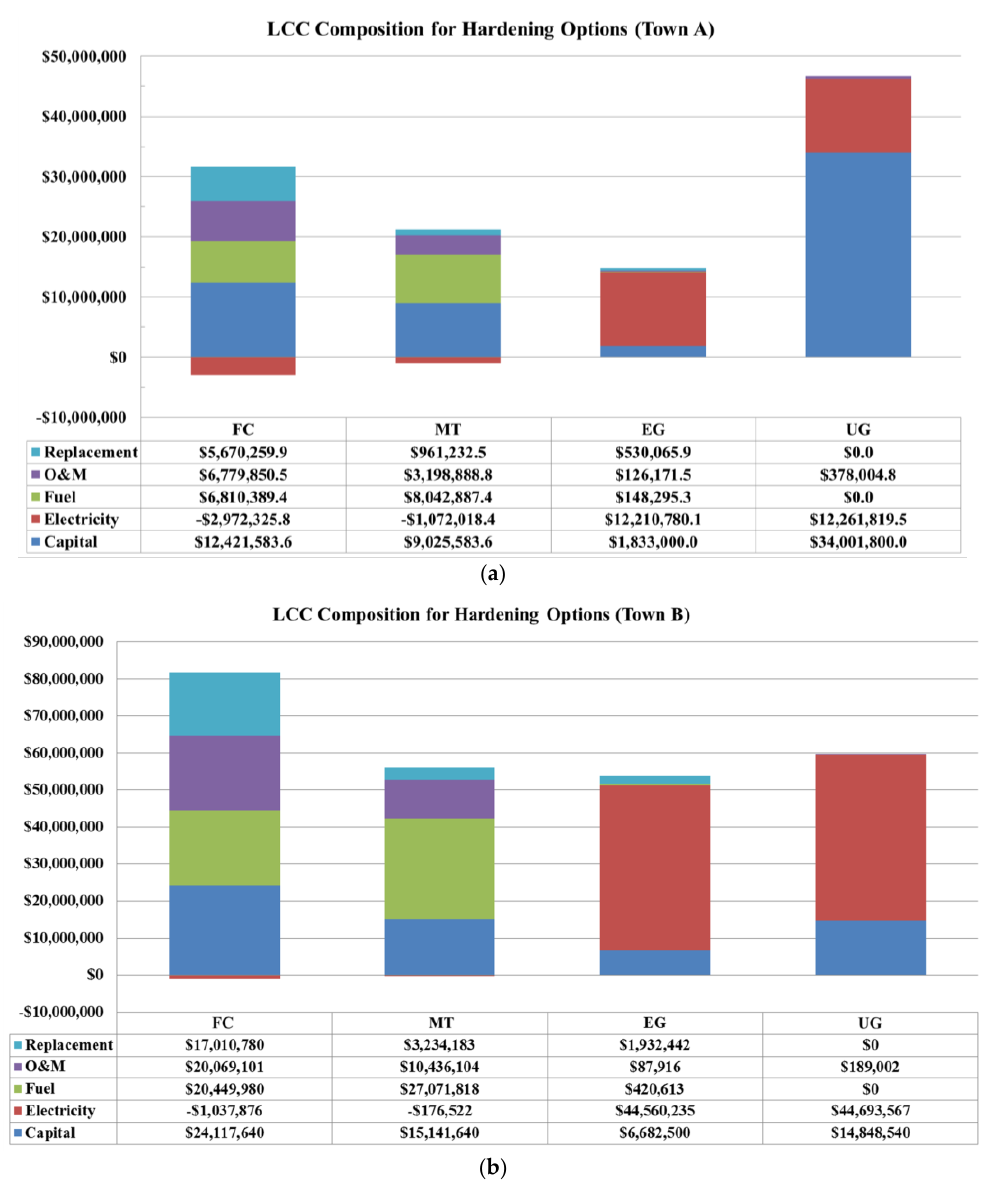
Figure 6. LCC compositions for hardening options: ( a ) Town A and ( b ) Town B.